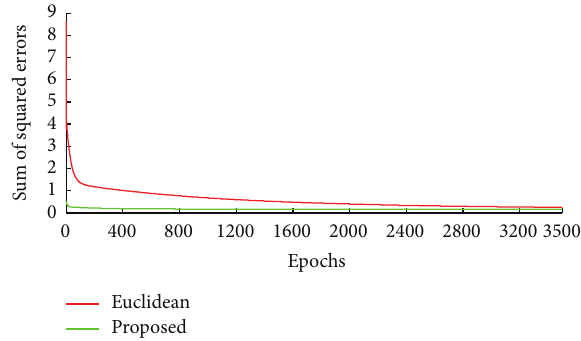
Figure 4: Comparative objective function plot showing difference in convergence for the two RBF kernels: Euclidean and proposed; proposed kernel converges faster than its conventional